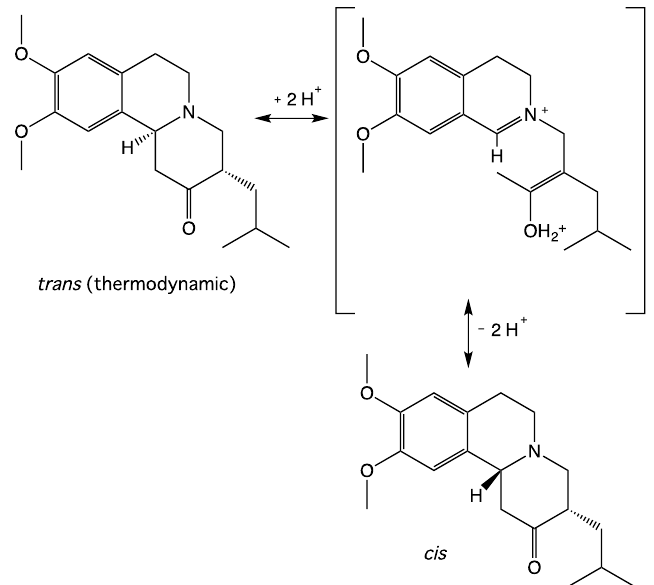
Figure 2. Hypothetical interconversion between trans -TBZ and cis -TBZ (only one enantiomer is depicted) in acidic medium.